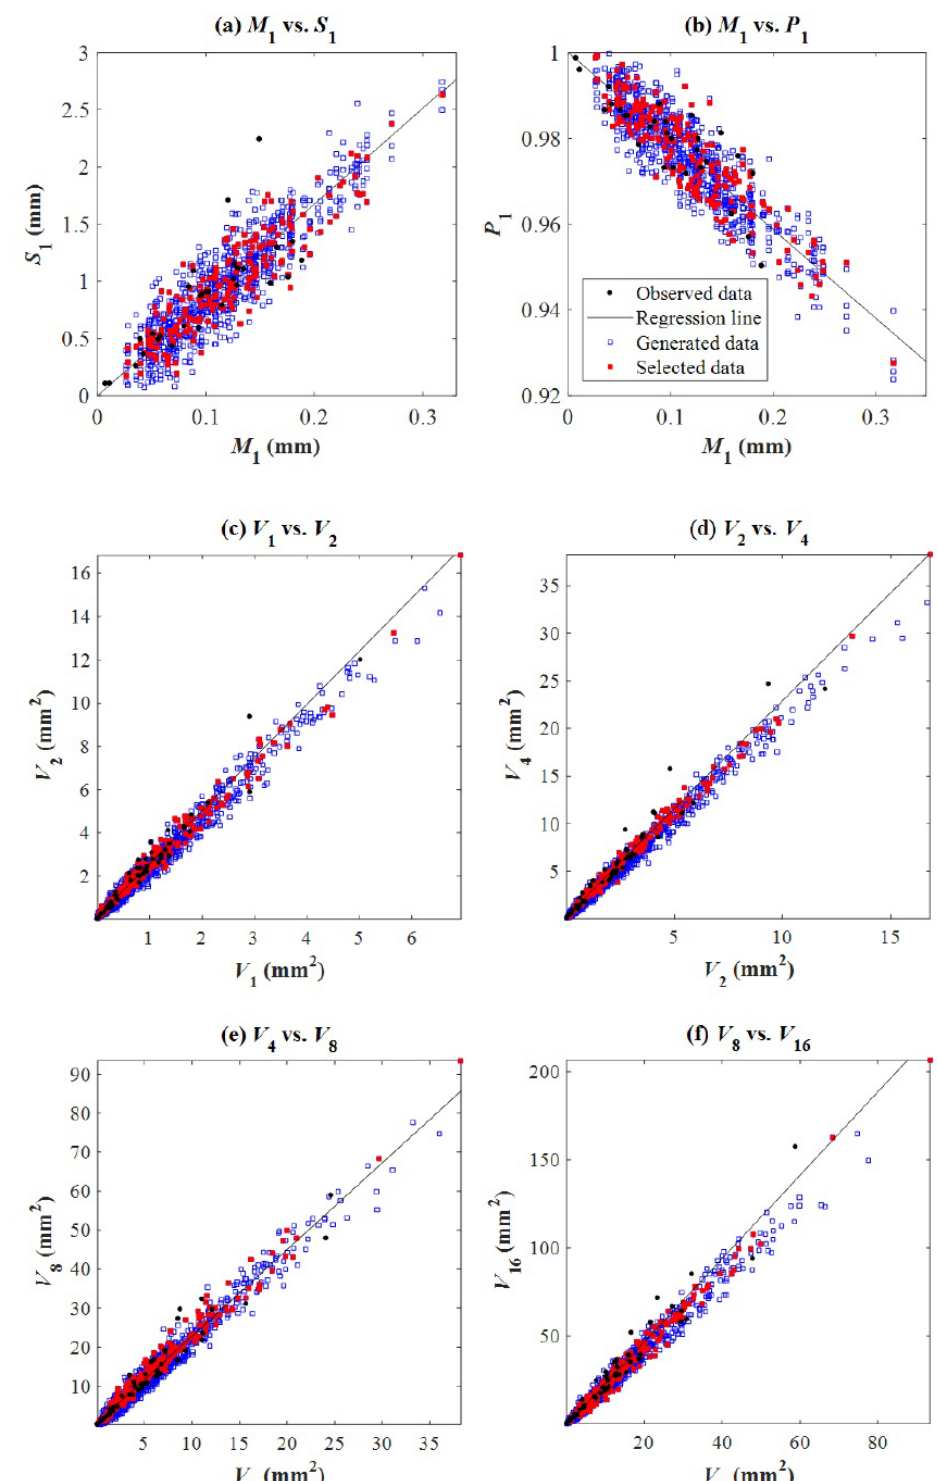
Hydrol. Earth Syst. Sci., 23, 989–1014, 2019